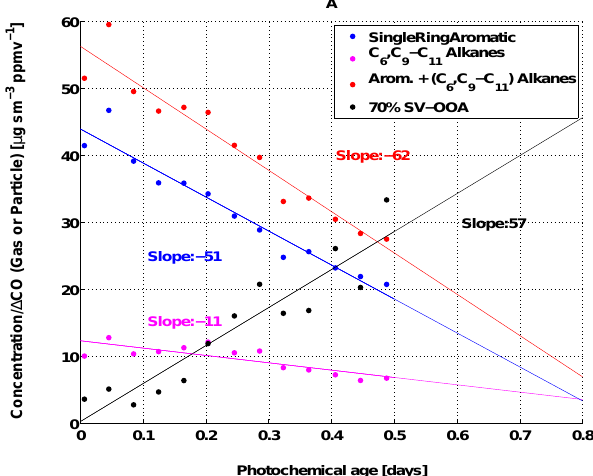
Fig. 4. Measured PMF OOA factor concentrations normalized by CO enhancement ( 1 CO is the ambient CO minus the estimated background CO, 105ppb) as functions of photochemical age. Also shown are lumped gas-phase VOC concentrations normalized by 1 CO. See Table 6 for the chemical speciation of each lumped